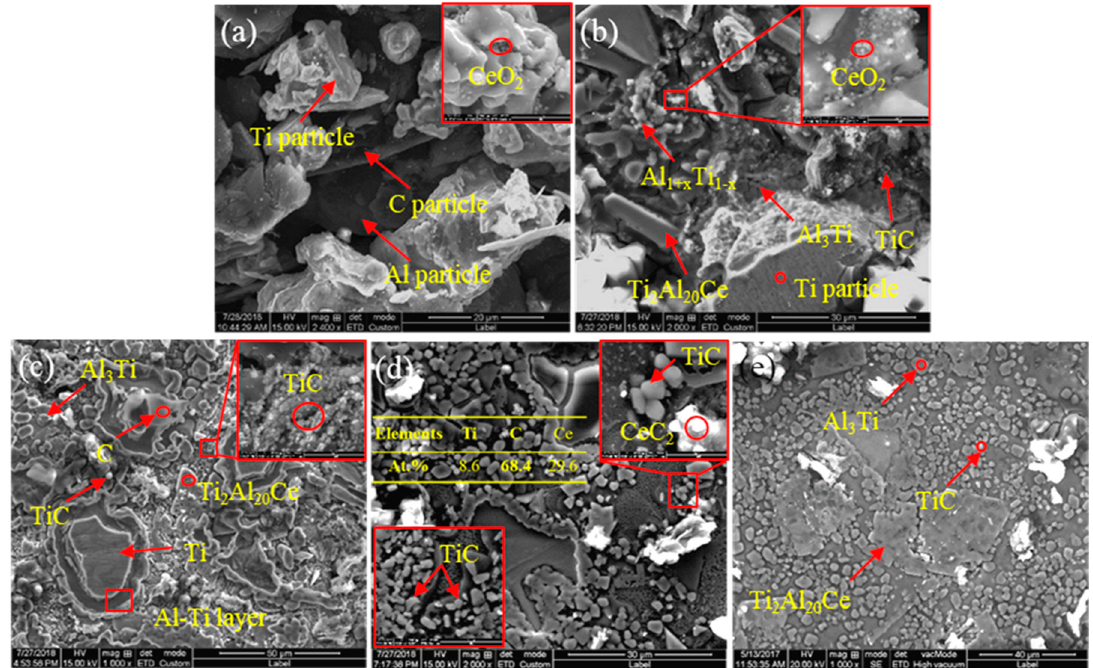
Figure 9. SEM images of #5 quenching samples prepared at different times: ( a ) 8; ( b ) 50; ( c ) 60; ( d ) 80 and ( e ) 90 s.